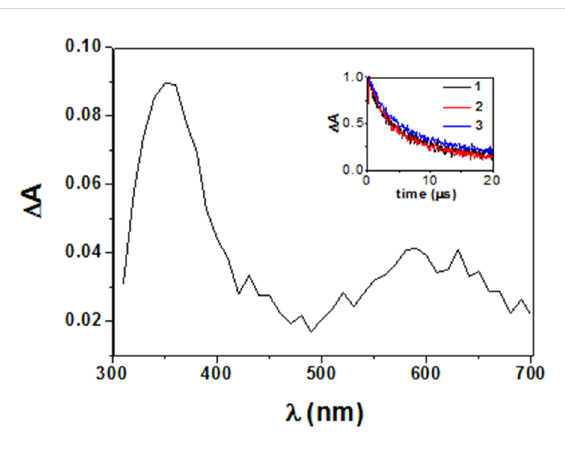
Figure 6: Transient absorption spectra for dyad 1 in CH 2 Cl 2 1 μ s after laser pulse ( λ exc = 355 nm). Inset: Normalized decays of the triplets generated from dyads 1 – 3 monitored at 620